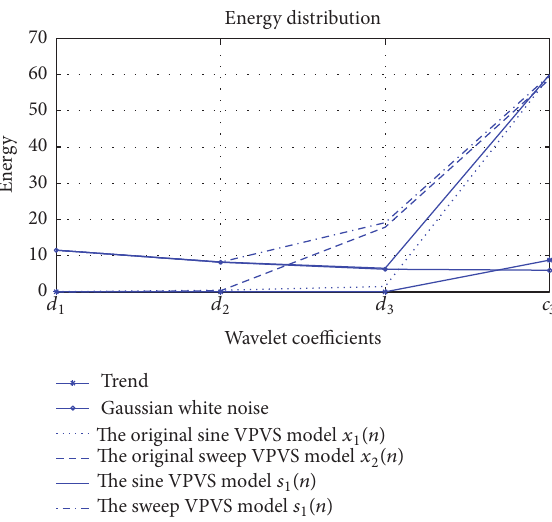
Figure 6: The original sine VPVS model and sine VPVS model.